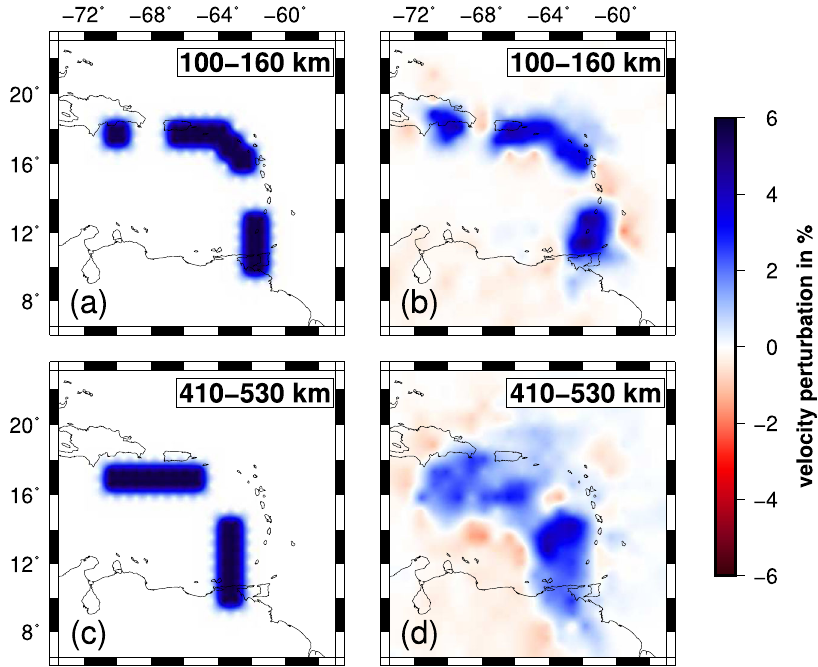
Fig. 9 Resolution tests for potential gaps in the slabs. a , b Input and output in the shallow mantle (local-grid layer 3 between 100 and 160 km depth). c , d Input and output for the transition zone (local-grid layer 7 between 410 and 530 km depth). For input and output for all layers, see Supplementary Figs. 7 and